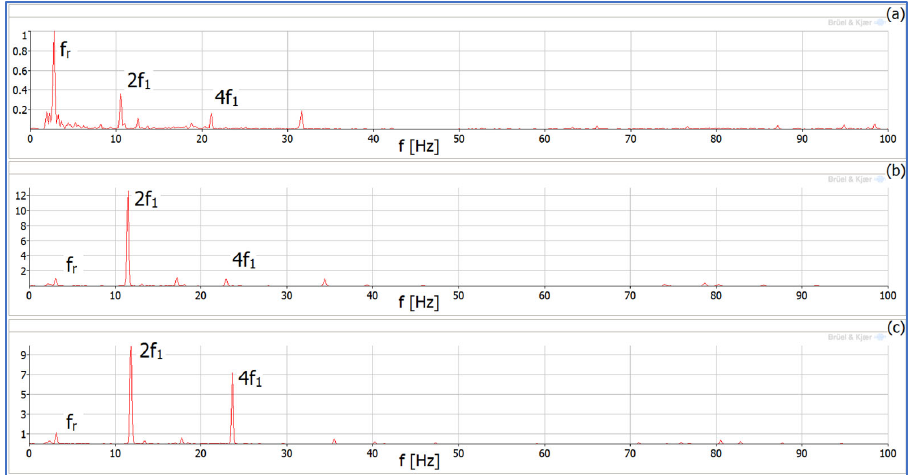
Figure 12. Vibration spectral characteristics for a rotational speed of 150 rpm and under load, where